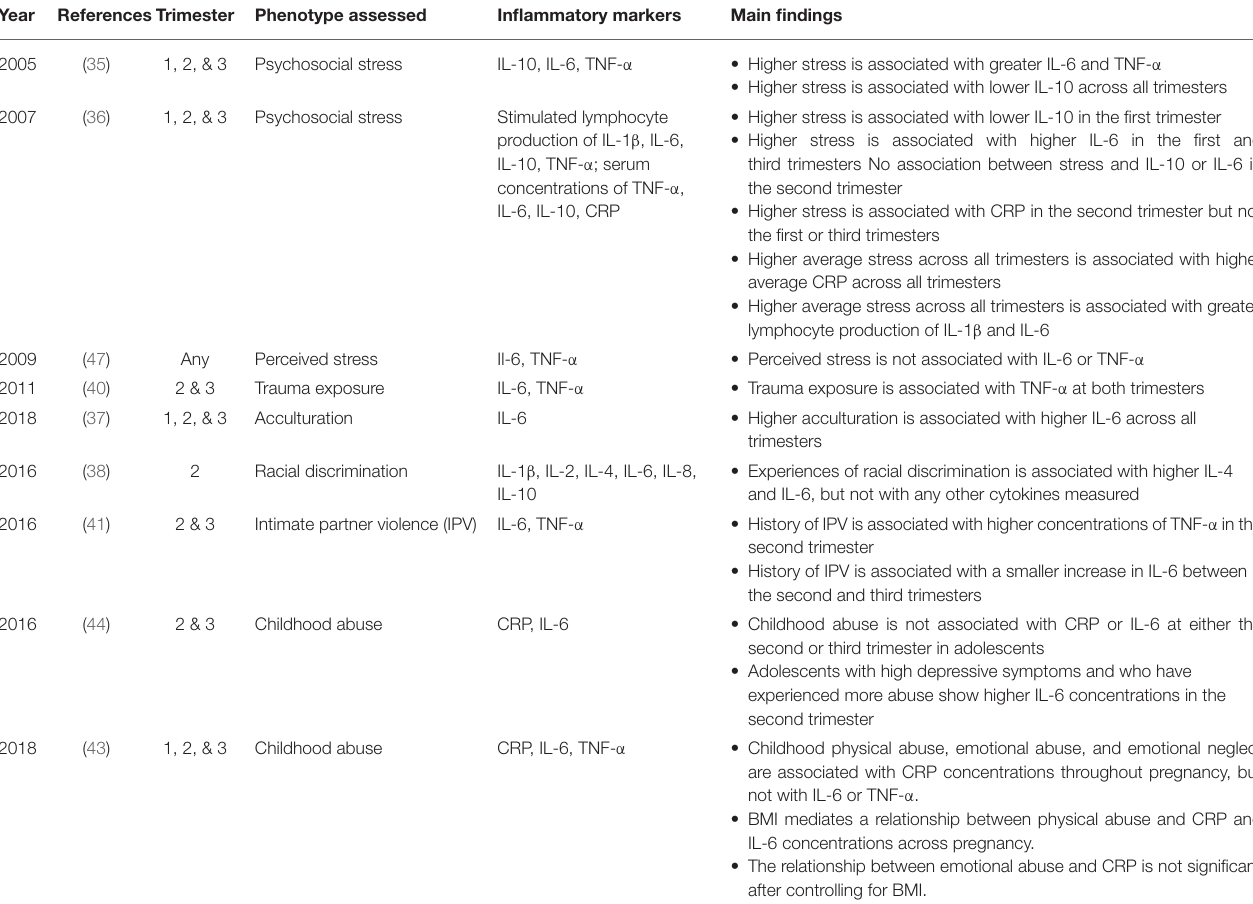
TABLE 1 | Stress/Trauma exposure and systemic inflammation in